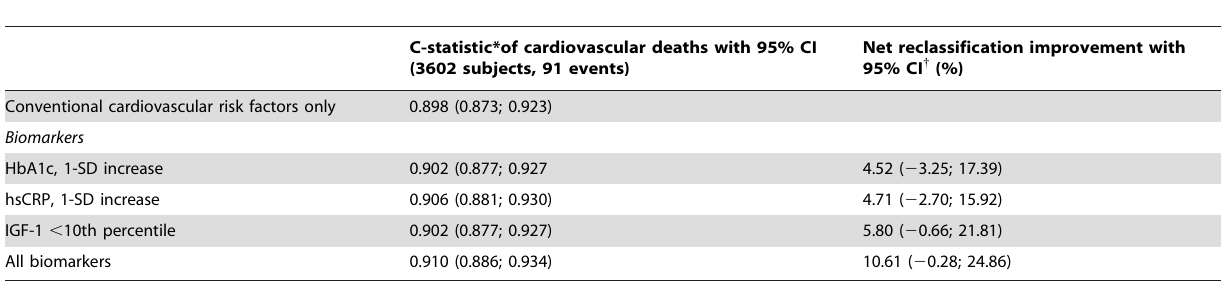
Table 6. Improvement of prediction of cardiovascular death by